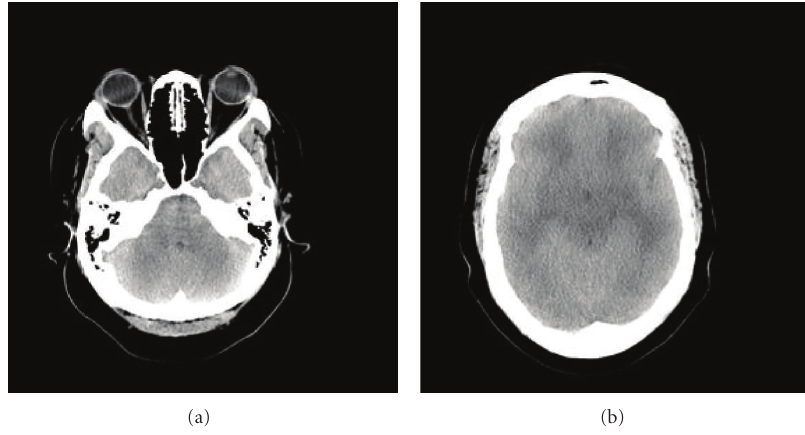
Figure 1: (a, b) Axial CT scans demonstrating di ff use cerebral edema on